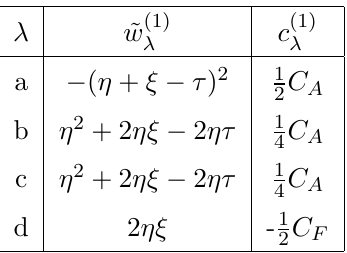
and the color factors c (1) (cid:21)